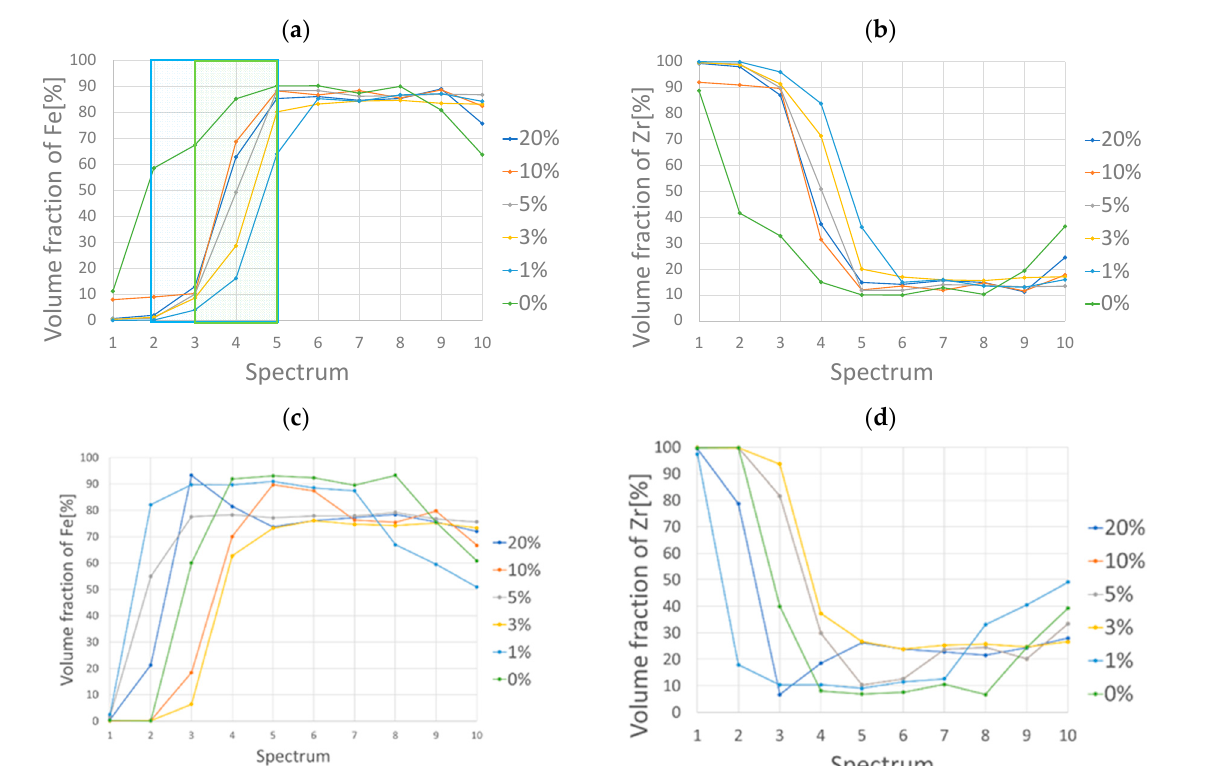
Figure 9. Results of element analysis for the samples with rotating speeds of 250 rpm and 1000 rpm with different amounts of dispersant of PCA. ( a ) for volume fraction (%) of Fe, and ( b ) for volume fraction (%) of Zr for 250 rpm. ( c ) for volume fraction (%) of Fe, and ( d ) for volume fraction (%) of Zr for 1000 rpm.